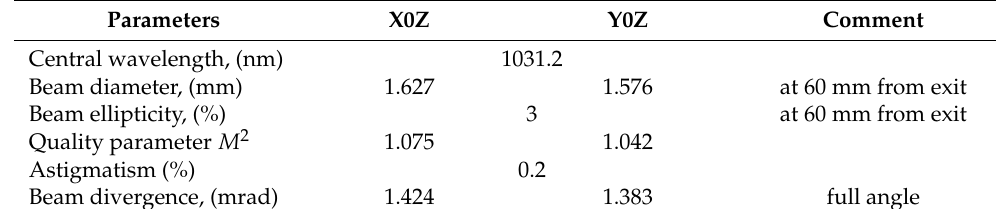
Figure 3. Experimental scheme consisting of a focusing lens and a CMOS-camera. The planes ( a – c ) show the cross-sections of the intensity distributions captured along the propagation axis. The plane ( d ) marks the longitudinal section of the intensity distribution.